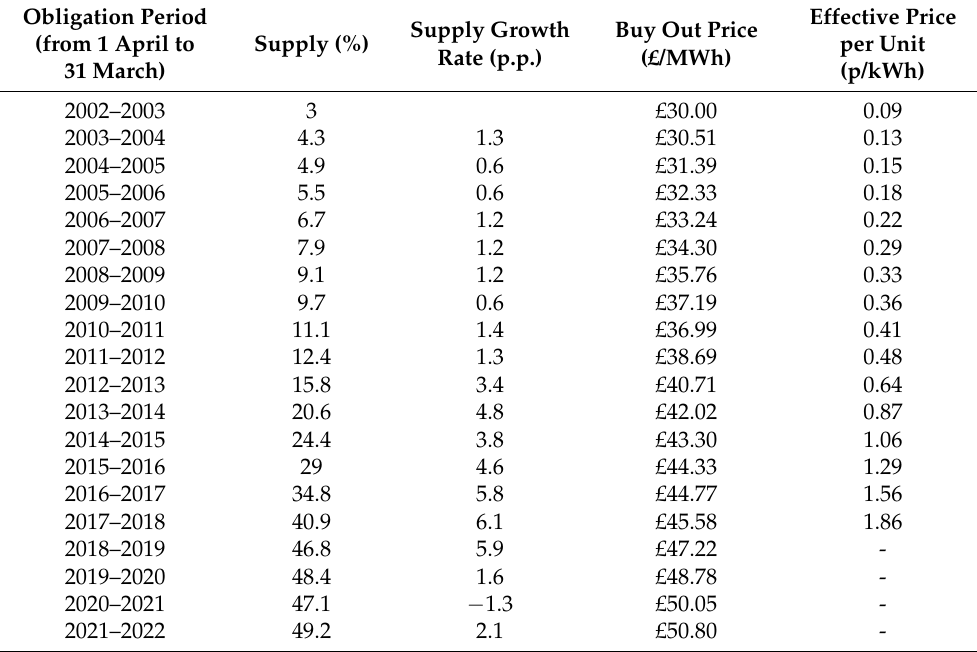
Table A2. Standard Bass model estimates ( α , q , m ) by sector for installed capacity and number of installations.